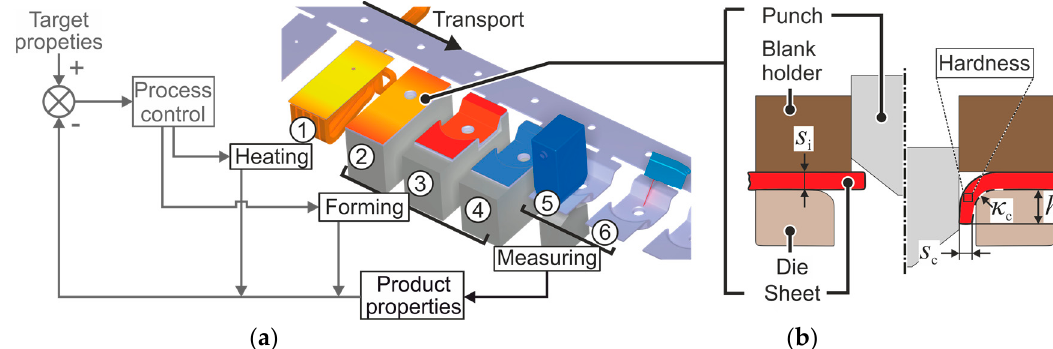
Figure 1. ( a ) Process design for multi-stage hot sheet metal forming in a progressive-die with a closed loop control of product properties; ( b ) Principle of hot hole-flanging and product properties: collar height h c , thickness of the collar s c , curvature of the collar κ c , and hardness.